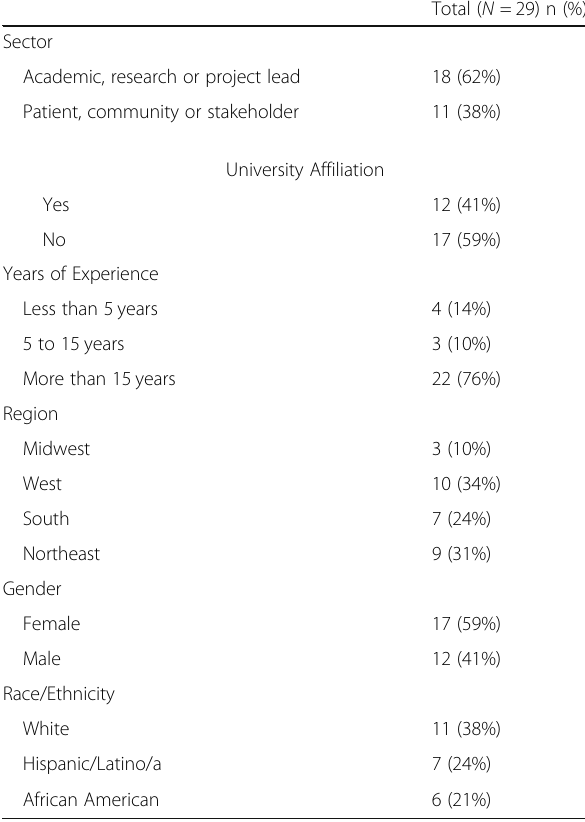
Table 2 Demographics of participants from original